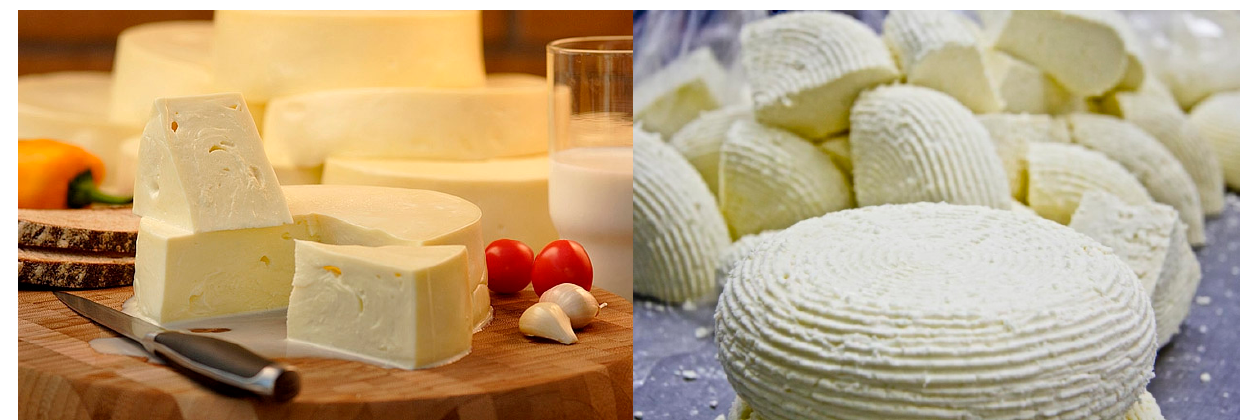
Figure A1. Imeruli and Sulguni cheese, respectively (Source: https://georgianjournal.ge/georgian ‐ cuisine/32138 ‐ georgia ‐ among ‐ top ‐ 10 ‐ countries ‐ on ‐ the ‐ world ‐ cheese ‐ map.html, accessed date: 11 September 2021).